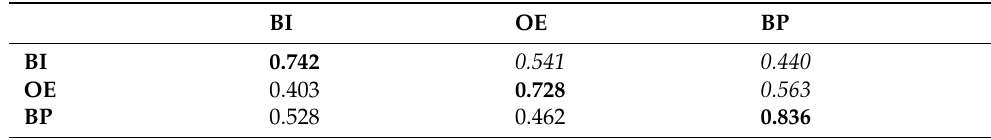
Table 3. Discriminant validity with